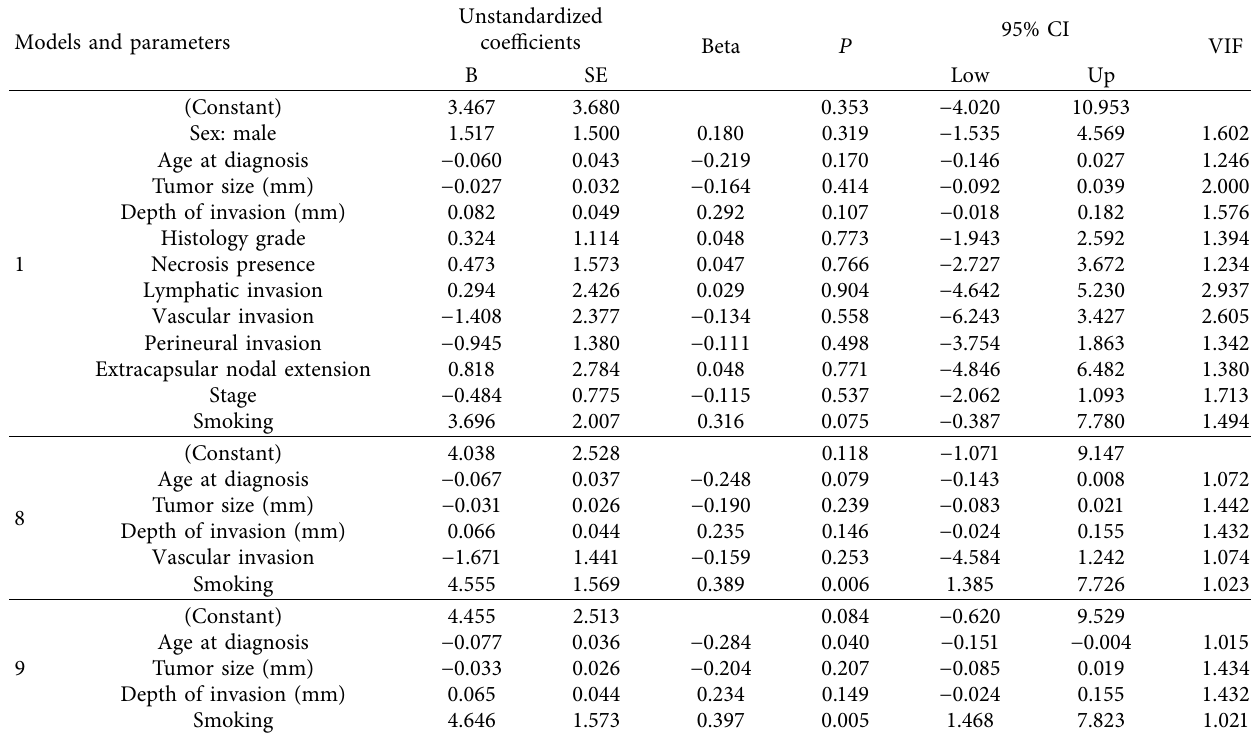
Table 2: Factors associated with the ΔΔ Ct CD16, calculated using the backward-selection stepwise log-level multiple linear regression. Models and parameters